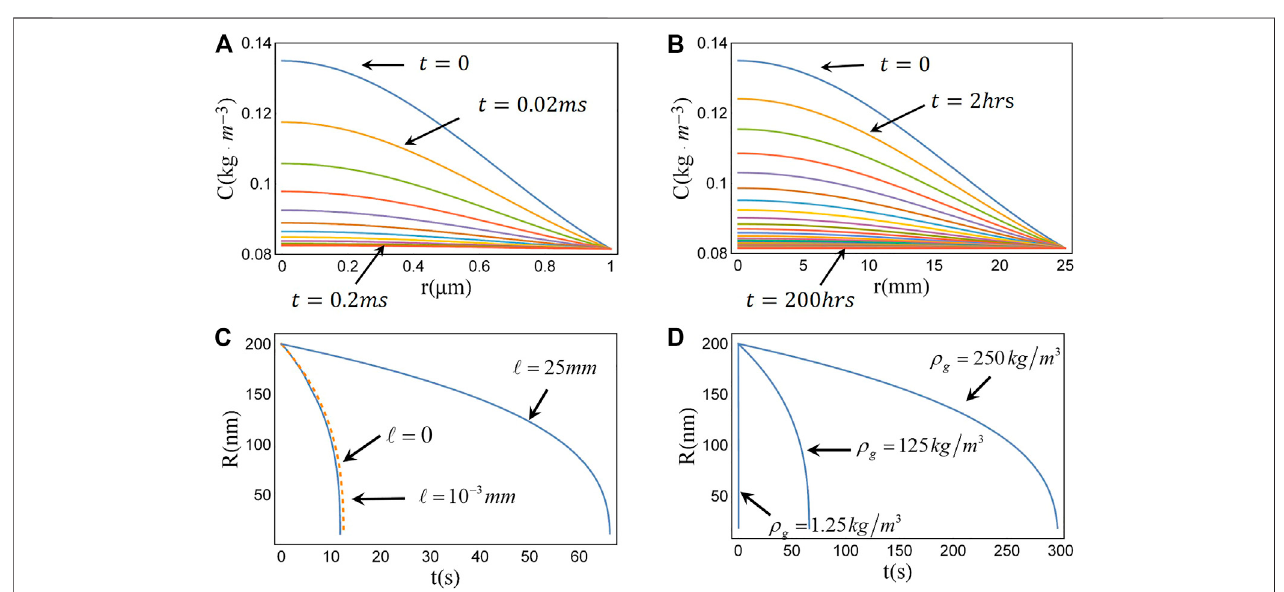
FIGURE2| Evolutionofgasconcentrationaroundthesinglebulknanobubbleandthedissolutionprocessofsinglebulknanobubblewithdifferentconditions. (A) In the initial moment, the gas is uniformly distributed in the fl uid layer with 1 μ m. At t = 0.2 ms, the gas concentration reaches an equilibrium. (B) When the liquid layer thicknessis25 mm,thegasdiffusionnearasinglenanobubblereachesequilibrium200 hlater,indicatingthatthegasnearthenanobubbleformsalong-time “ traf fi cjam effect ” . (C) The dissolution times of bulk nanobubbles at different positions (gas diffusion distance is different) in the container while supposing inner density of bubble was ρ g (cid:1) 125 kg / m 3 . (D) The dissolution times of bulk nanobubble with different inner densities as that proposed in Zhang et al. (2008) while supposing gas diffusion distance was ℓ (cid:1) 25 mm (located a certain distance inside of the container).